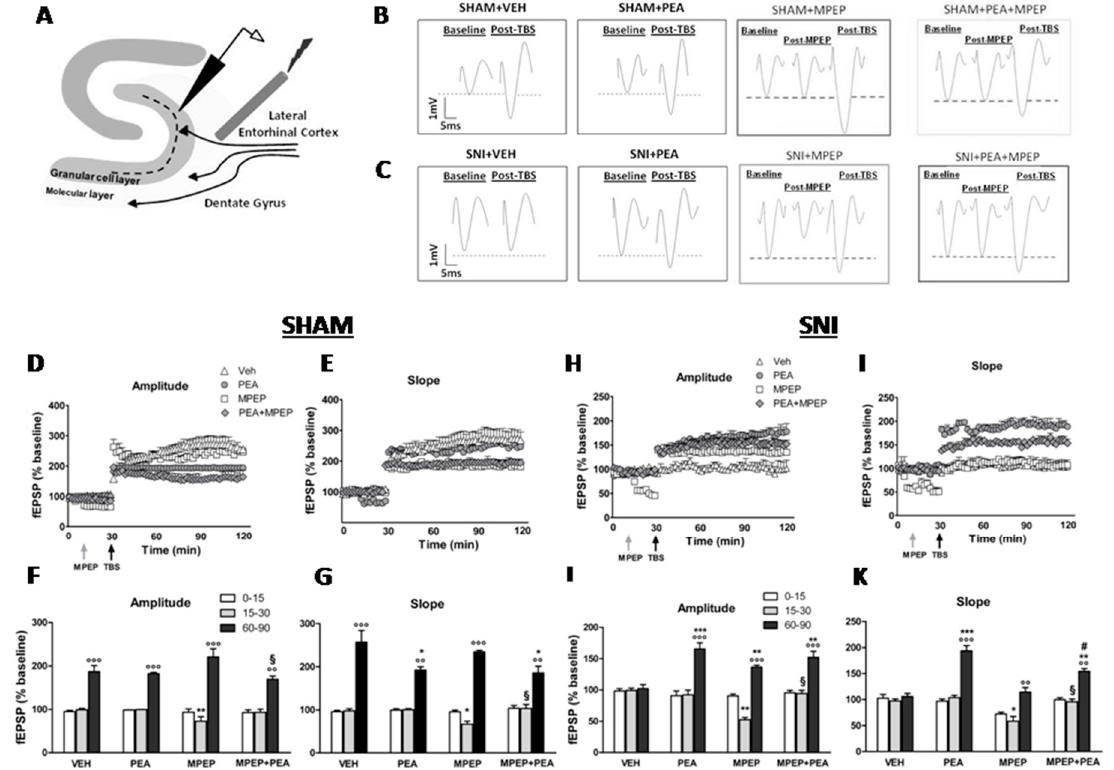
Figure 2. Effect of intra-LEC microinjection of vehicle or MPEP (5 nmol) on the LTP at the LEC-DG pathway in sham and SNI mice treated with vehicle or with PEA (10 mg/kg, i.p.) for two weeks. ( A ) shows a schematic illustration of electrode placements with the stimulating electrode in the LEC for stimulating the lateral perforant path (LPP) fibers and microinjecting drug or vehicle solutions and the recording electrode in the DG for recording the fEPSPs of the granular cells. ( B , C ) show sample traces of a single evoked fEPSP recorded in the DG during baseline, after MPEP microinjection into the LEC or TBS application in both, sham ( B ) or SNI ( C ) mice treated with vehicle or PEA. ( D – F ) show time-dependent changes in the amplitude ( D , H ) and slope ( E , I ) of fEPSPs after vehicle or MPEP (5 nmol) microinjection in vehicle or PEA-treated sham ( D , E ) or SNI ( H , I ) mice. ( F , G , J , K ) show the average of normalized amplitude ( F , J ) and slope ( G , K ) of fEPSPs at different time points (0–15, 15–30 and 60–90 min) after microinjection of MPEP (15–30) or TBS application (60–90) normalized to basal responses in vehicle or PEA-treated sham ( F , G ) or SNI ( J , K ) mice. Data are represented as mean ± SEM of the amplitude and slope of fEPSPs. ◦ Indicate significant differences vs. pre-TBS (15-30 min), * indicates significant differences vs. vehicle-treated mice, # indicates significant differences vs. PEA-treated mice and § indicate significant differences vs. MPEP microinjection. p < 0.05 was considered statistically significant. Vertical and horizontal scale bars indicate 1mV and 5ms, respectively. Grey arrow indicates intra-LEC MPEP microinjection and black arrow the TBS application.